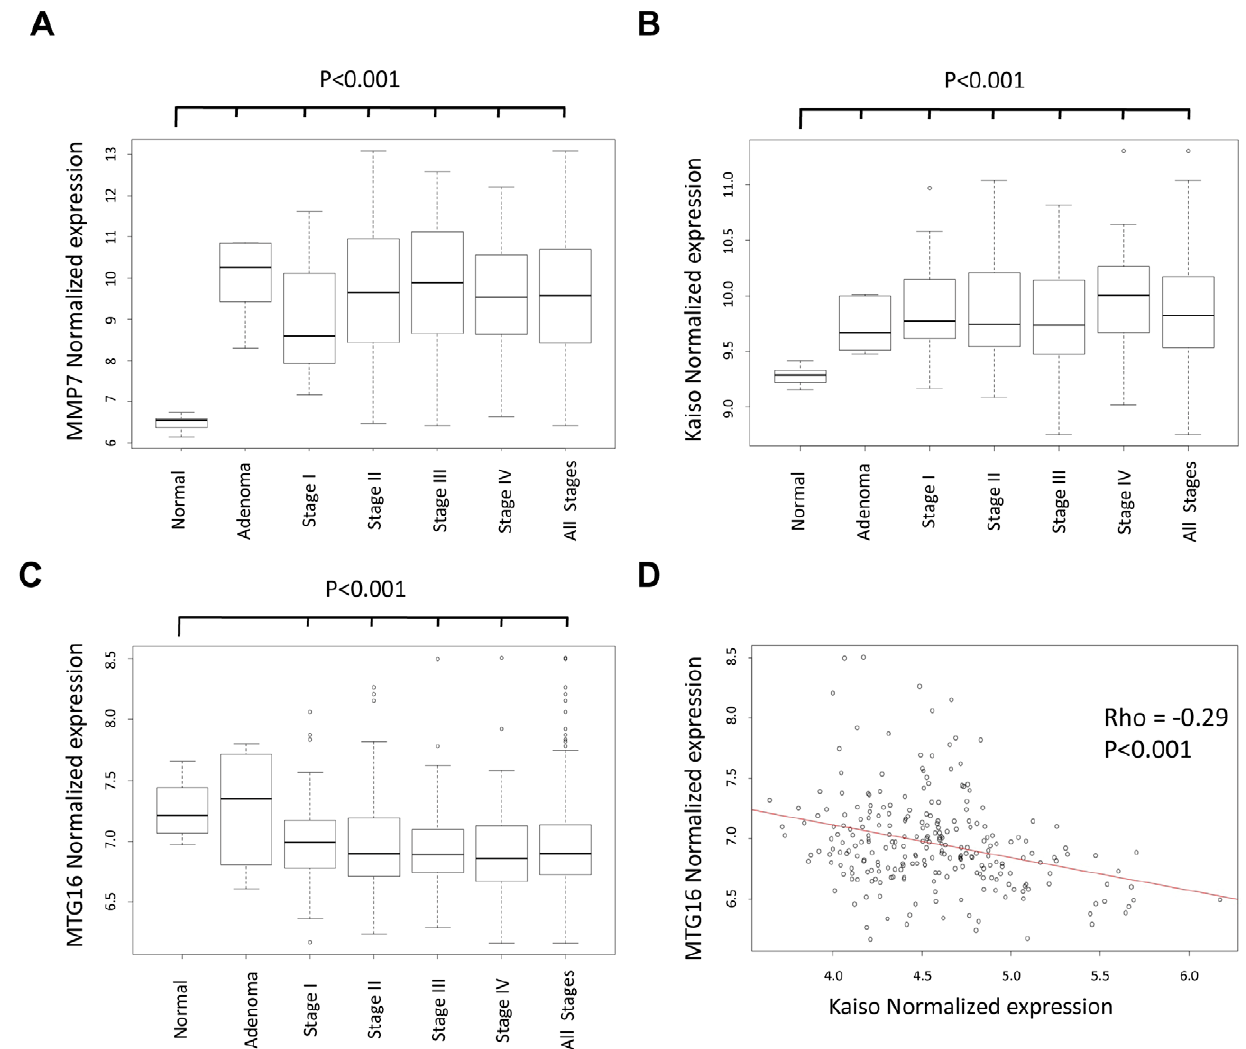
Figure 6. MTG16 and Kaiso are negatively correlated in human CRC patient samples and MMP-7 is up-regulated. A) Kaiso expression is significantly up-regulated in adenomas and colorectal cancer patients compared with normal adjacent colon tissues ( P , 0.001, for all comparisons). B) MMP-7 expression is significantly up-regulated in adenoma and colorectal cancer patients for each stage ( P , 0.001 for all comparisons). C) MTG16 expression is significantly down-regulated in colorectal cancers versus normal adjacent samples ( P , 0.001; *for all comparisons except adenoma). Wilcoxon Rank Sum test was used to determine significance for A–C. D) Normalized expression of both MTG16 and Kaiso probes (see Methods) were compared in human colorectal cancer patients. The graph demonstrates a significant inverse correlation for MTG16 versus Kaiso ( rho = 2 0.29, P , 0.001, inverse correlation depicted by red line, Spearman correlation coefficient).